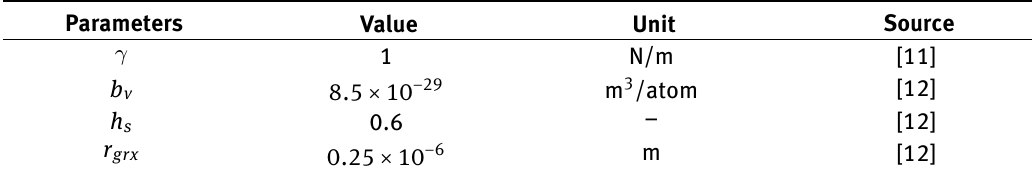
Table 1: Parameters used in the simulation